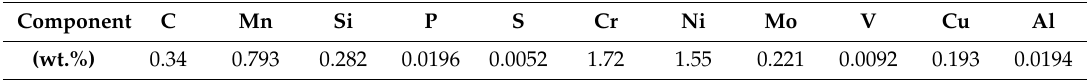
Table 1. Chemical composition of the 34CrNiMo6 steel.